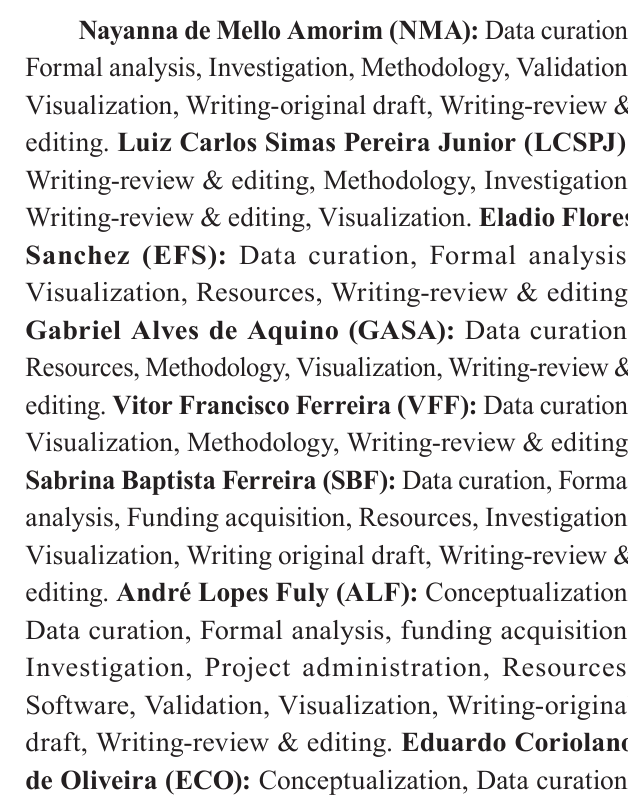
The physicochemical parameters evaluated were: lipophilicity (cLogP), solubility (LogS), molecular weight (MW), druglikeness, and drug-score of derivatives, predicted using the software Osiris ® Property Explorer and